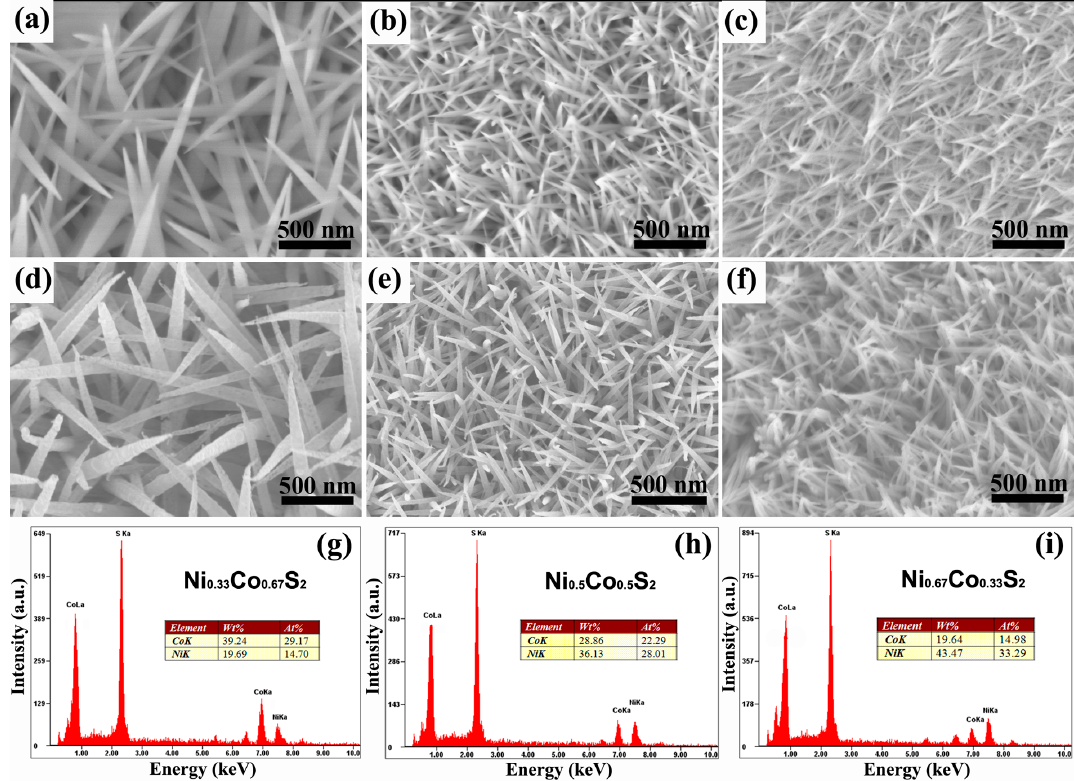
Figure 2. SEM images of the as-synthesized Ni–Co precursors ( a – c ), Ni x Co 1 − x S 2 ( d – f ) and EDS spectra. The corresponding Ni/Co molar ratios were 1:2 ( a , d , g ), 1:1 ( b , e , h ), and 2:1 ( c , f , i ), respectively.